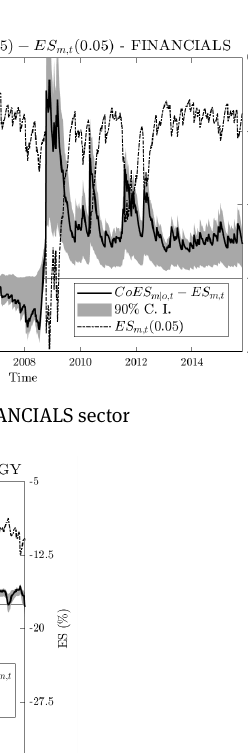
Figure 20c: CoES m | o , t (0.05, 0.05) for a certain sector given a bullish scenario for oil prices